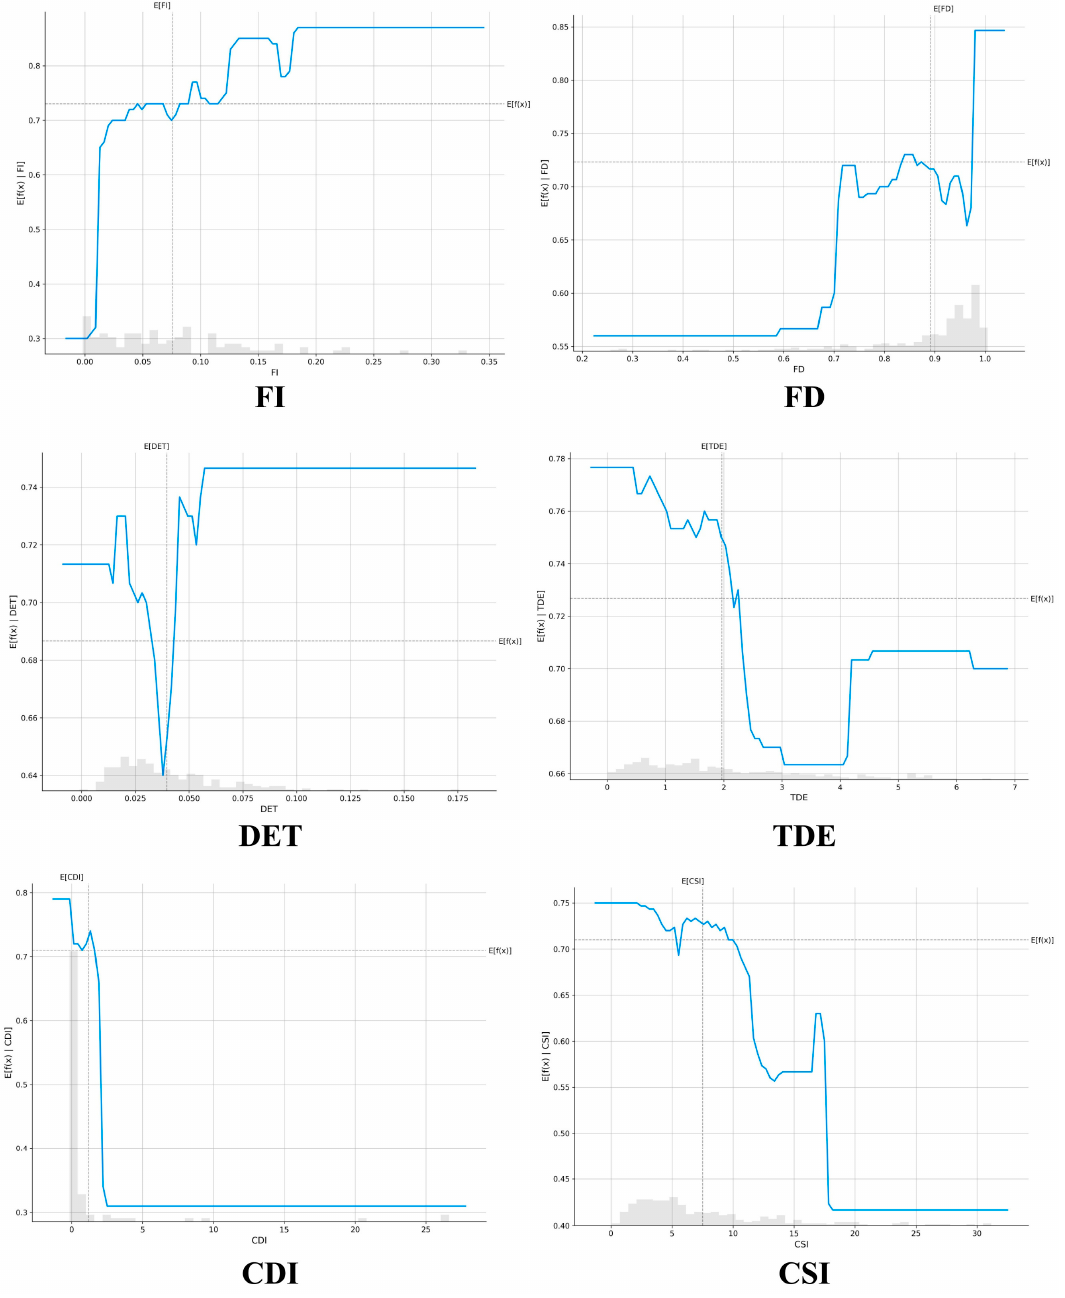
Figure 7. Nonlinear relationship between street green space morphology and LST using Shapley analysis.